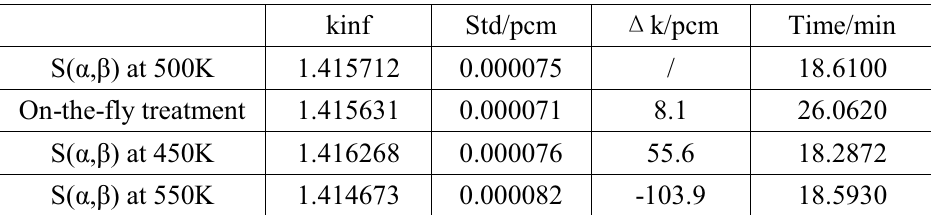
Table I. Comparison of kinf eigenvalues and efficiency